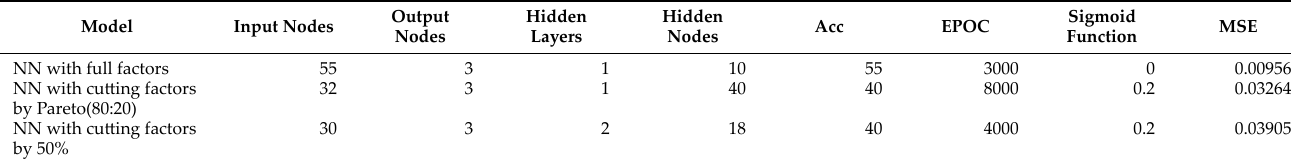
Table 7. Summary of model predicting the results of approval